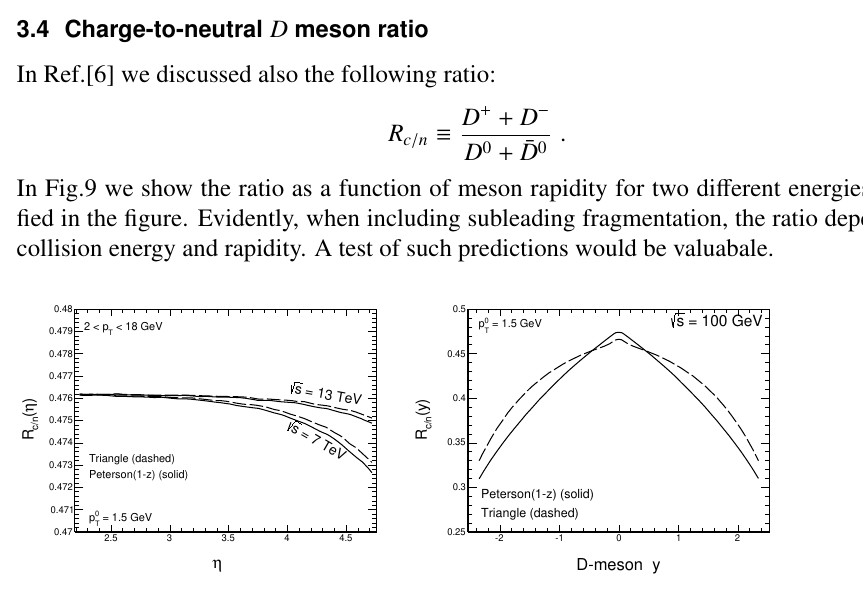
Figure 9. The R c / n ratio as a function of meson pseudorapidity for kinematics (left panel) and as a function of meson rapidity for (right panel). Only quark-gluon components (diagrams) are included here in calculating cross section for q and ¯ q